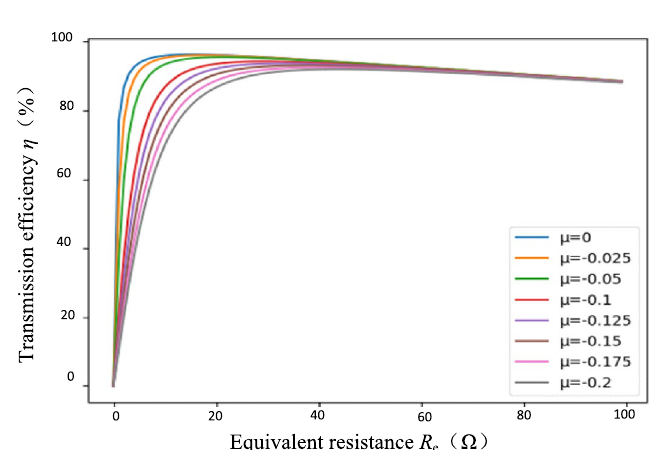
Figure 6. Efficiency–equivalent resistance curve under different detuning ratio μ.